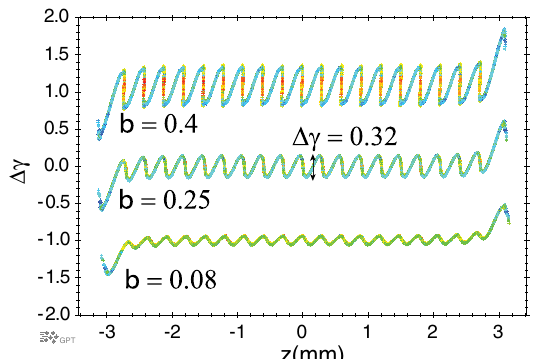
FIG. 4. Longitudinal phase spaces for initial condition below and above the wave-breaking condition.